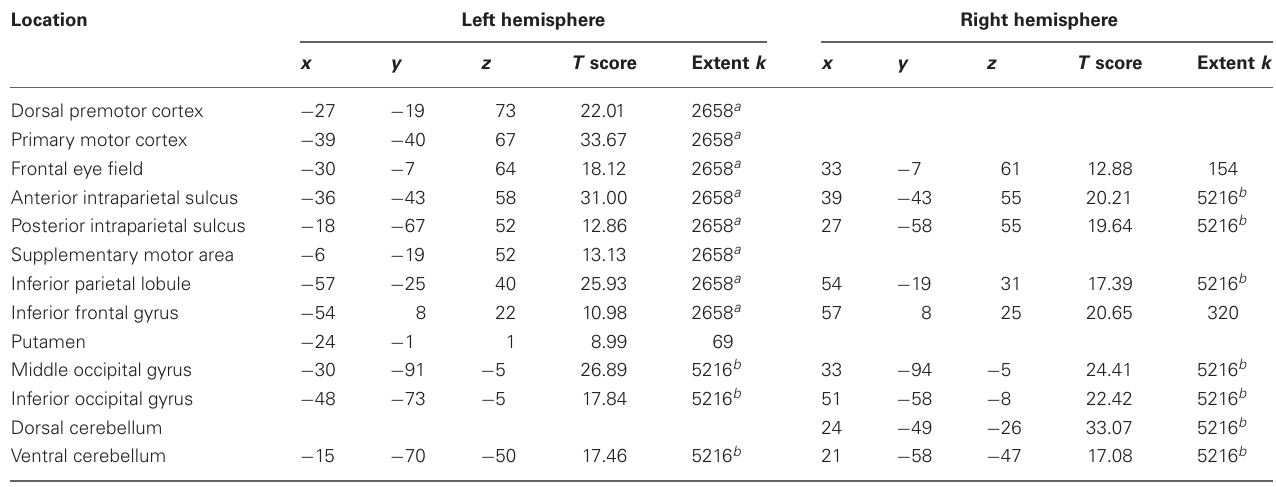
Table 3 | Main effect of task execution ( p < 0 . 05 corrected for family wise error, extent k > 25).